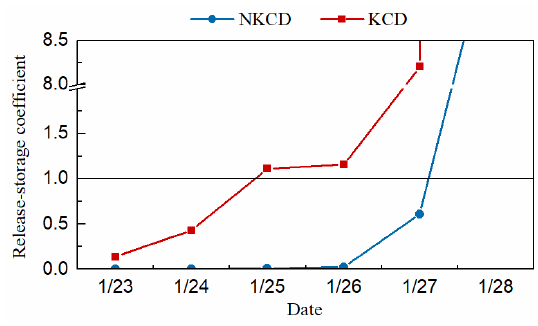
Figure 17. Release-storage coefficient of inner surfaces.